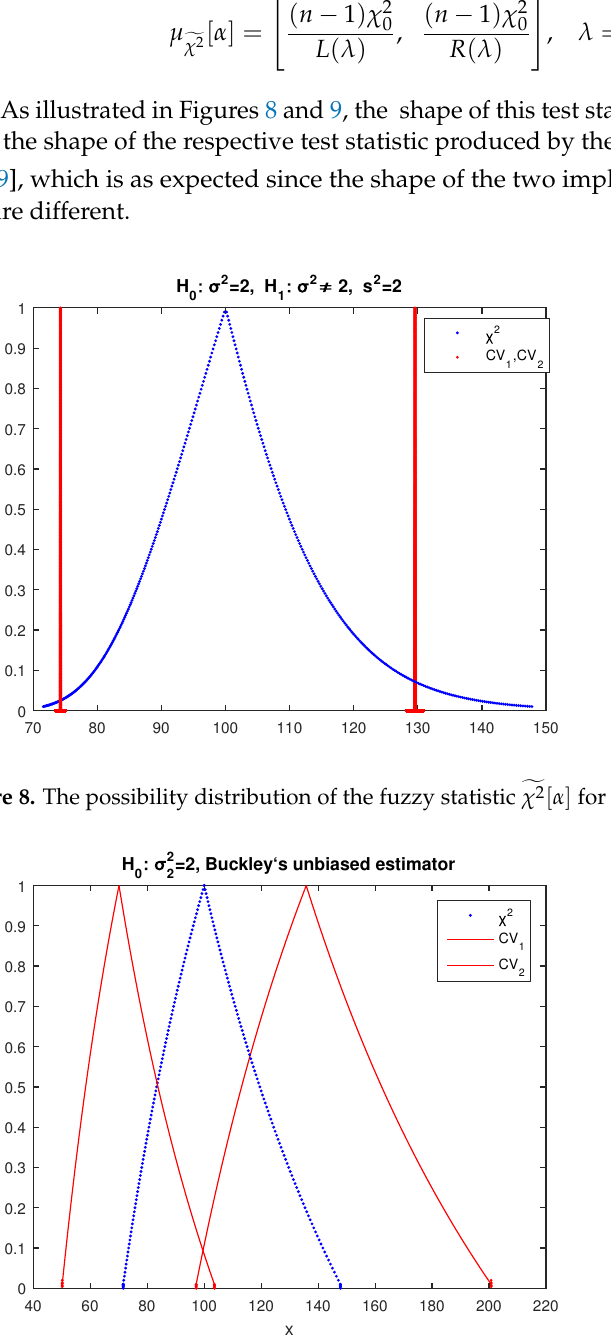
Figure 9. The possibility distribution of the fuzzy statistic (cid:102) χ 2 [ α ] and the fuzzy critical values for the respective test of H 0 of Example 3 in